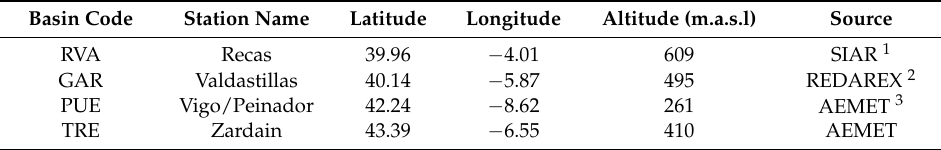
Table 3. Rain gauge station characteristics used in the